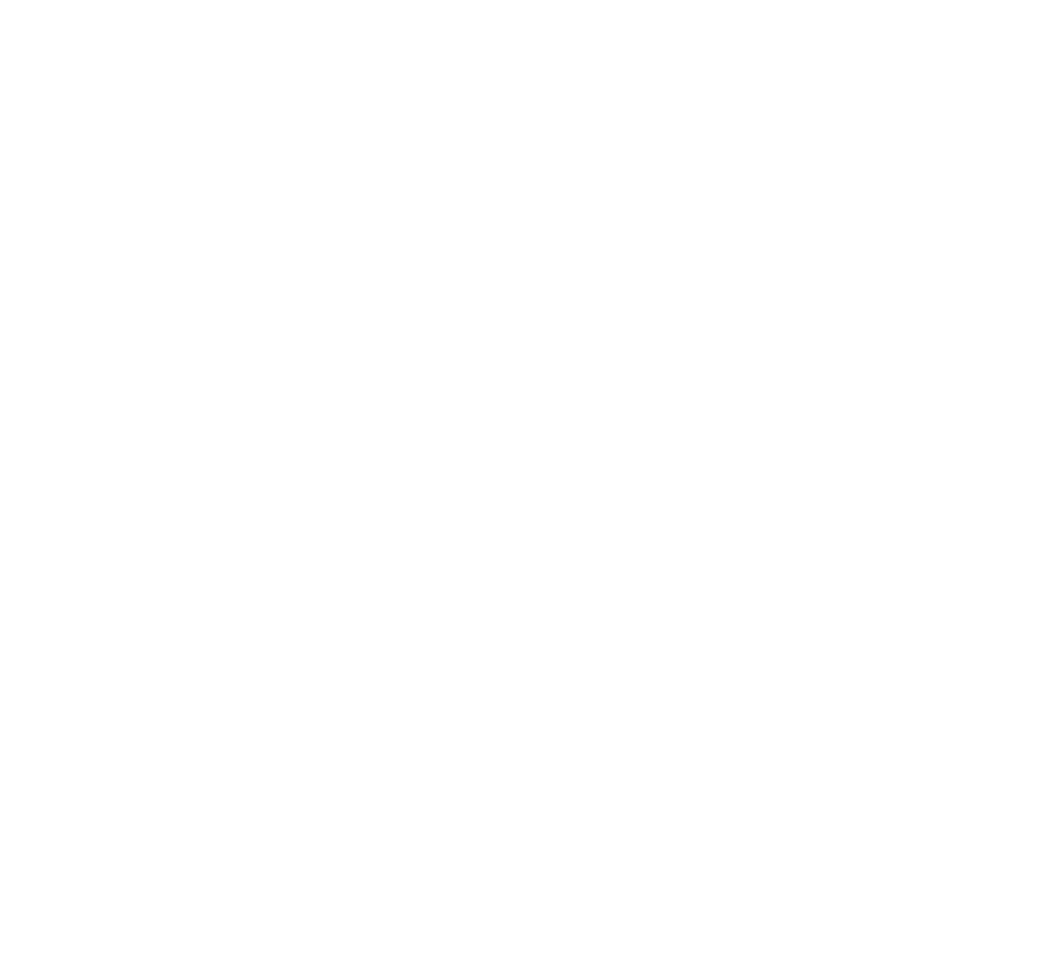
RSOD frequency transitions from baseline (BL) to follow-up (FU) (N =